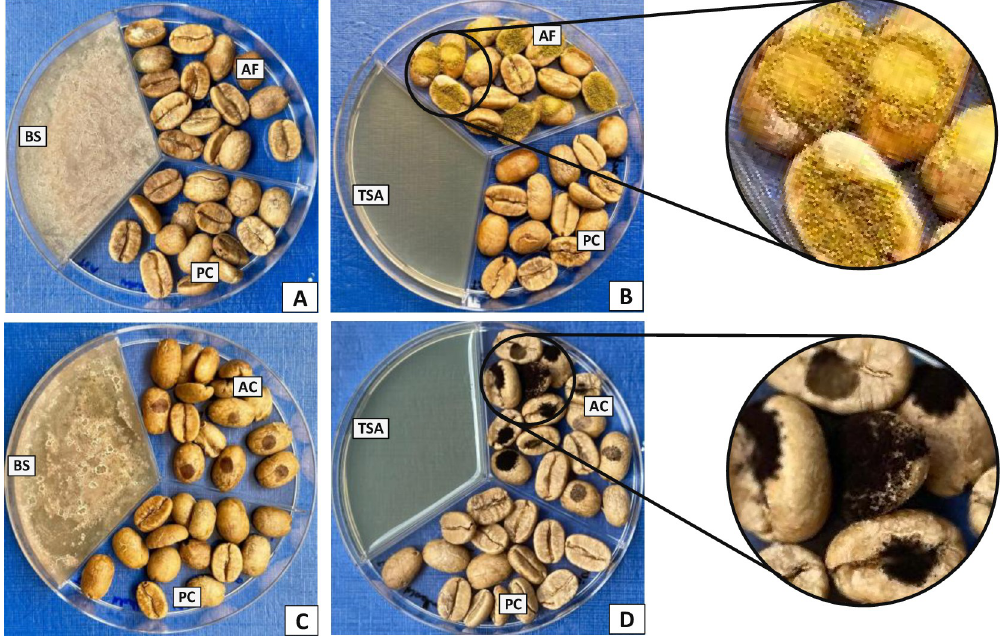
Fig 4. In vivo antagonistic activity of Bacillus simplex 350–3 volatiles against the growth of toxigenic fungi on infected coffee beans. There was a significant growth of A . flavus (B) and A . carbonarius (D) on coffee beans in the absence of B . simplex volatile, compared to complete inhibition of fungi in A and B in the presence of bacterial volatile. BS ( Bacillus simplex on tryptic soy agar); AF (coffee beans infected with Aspergillus flavus ); PC (Plain coffee beans); AC (coffee beans infected with Aspergillus carbonarius ); TSA (tryptic soy agar without any